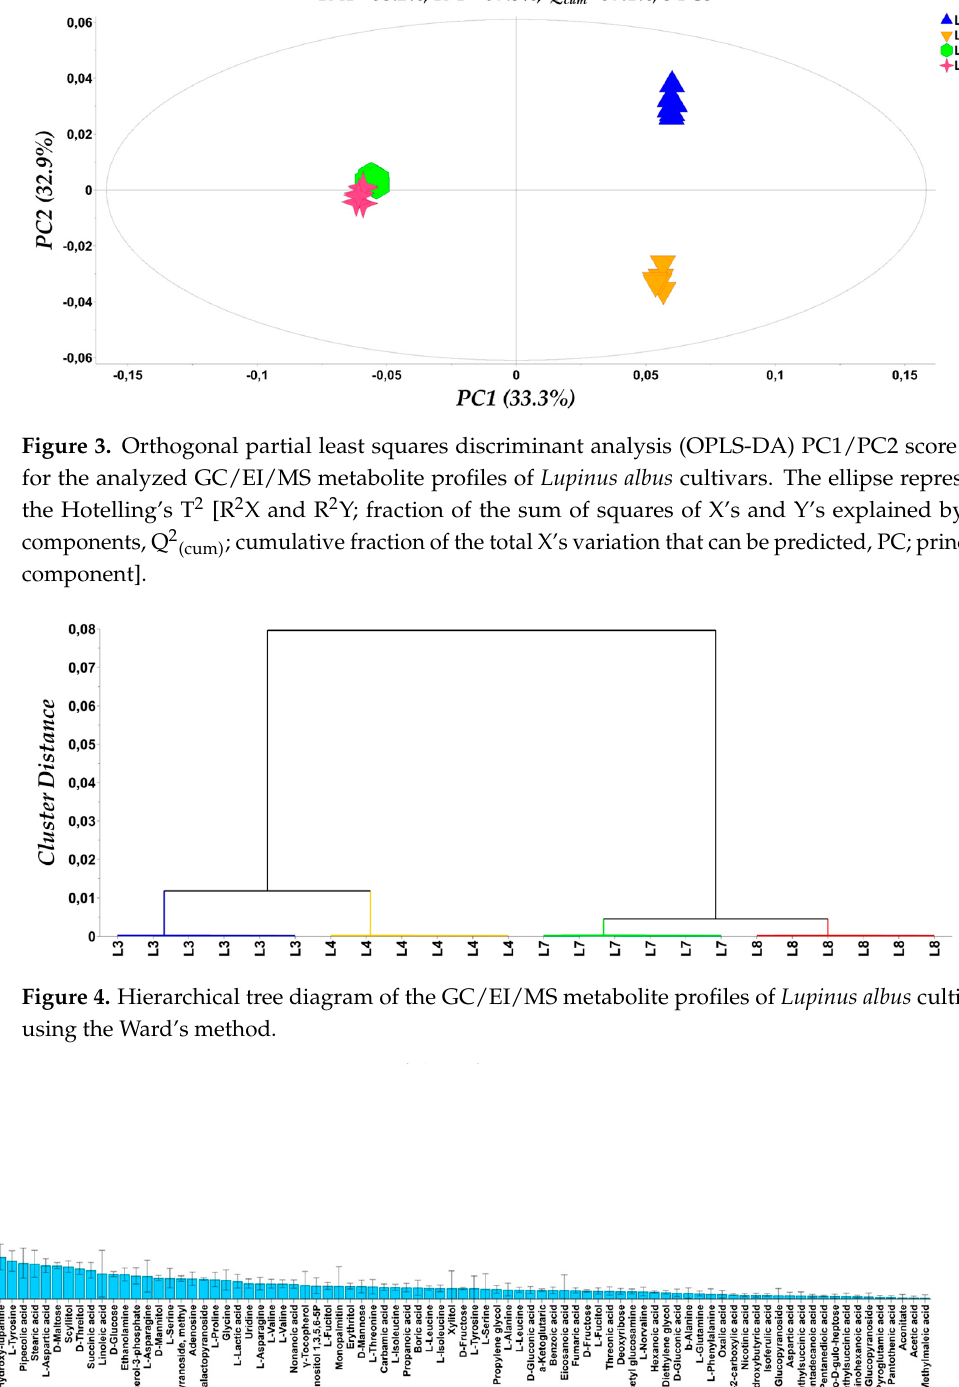
Figure 5. Variable influence on projection (VIP) plot, displaying the VIP values of the annotated Lupinus albus cultivar seeds’ metabolites and the corresponding jack-knife uncertainty bars. High VIP values correspond to metabolites with high leverage to the observed separation among